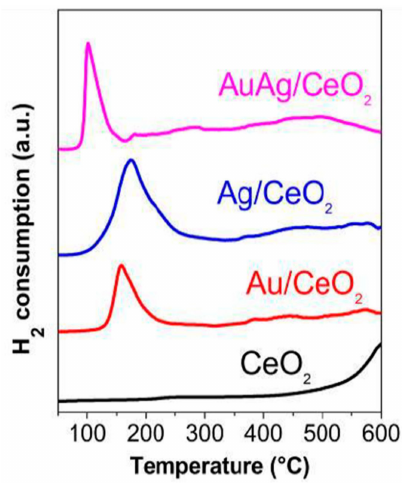
Figure 5. H 2 -Temperature Programmed Reduction curves of the investigated